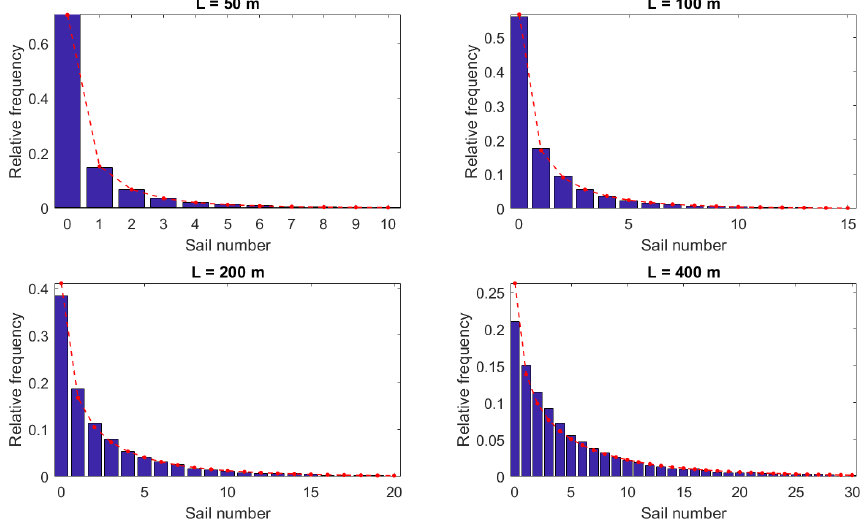
Figure 3. Negative binomial fits to the RSN distribution for the full lidar dataset and for different segment lengths.